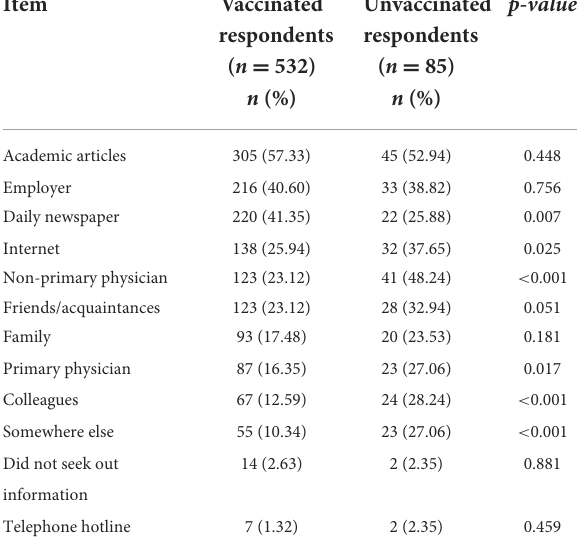
TABLE 5 Feelings related to vaccine mandate and employer